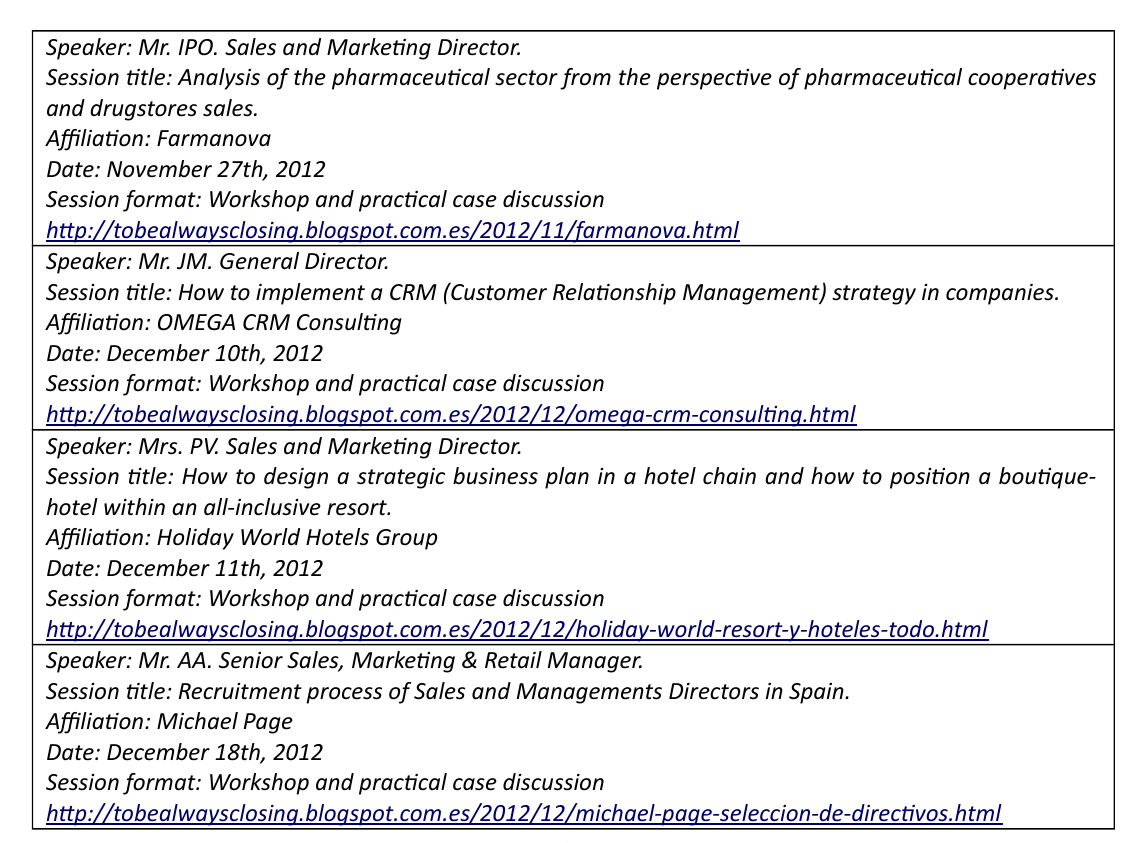
Table 2. List of guest